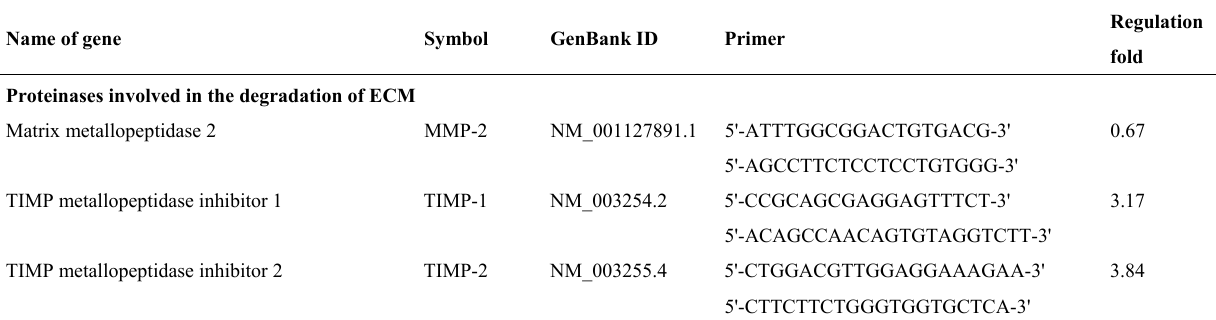
Table 2. Modulated genes relative to control after treatment of xenografts with